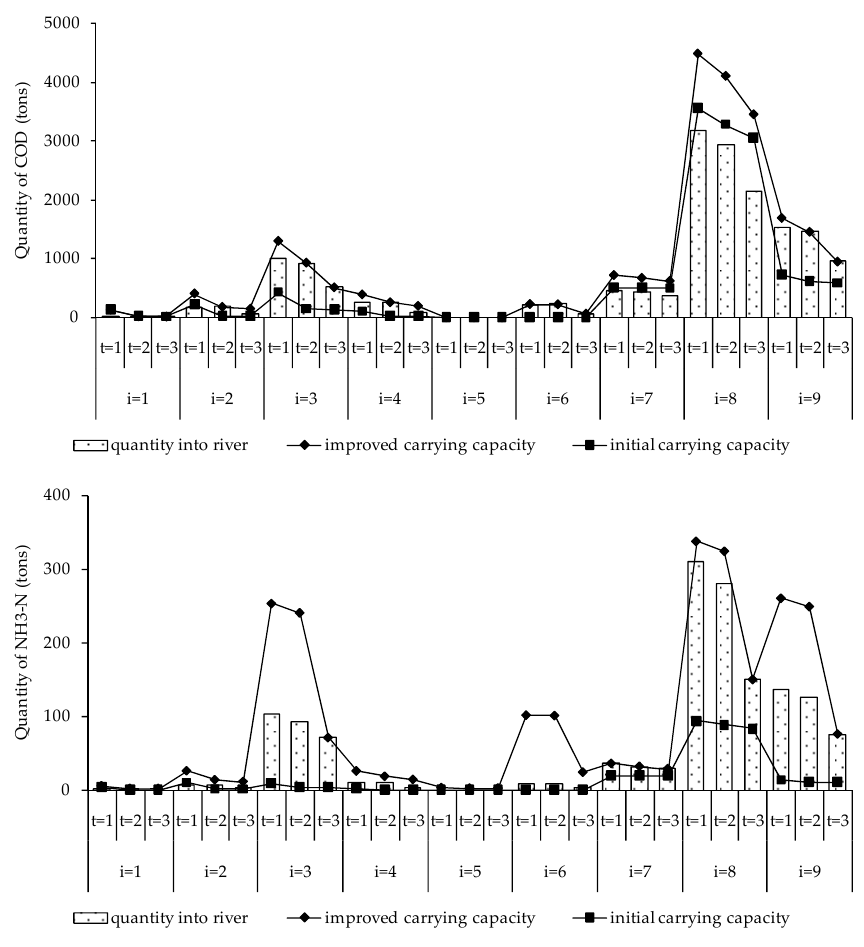
Figure 9. Environmental carrying capacities and pollutants into the Yitong River under the high flow level.